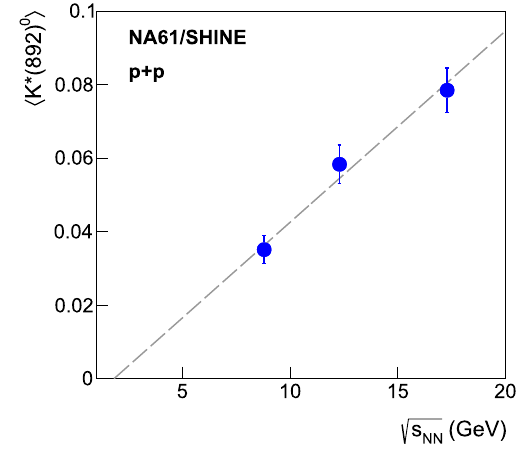
Fig. 9 The energy dependence of (cid:8) K ∗ ( 892 ) 0 (cid:9) in inelastic p+p col- lisions. The previous NA61/SHINE result [9] for p+p interactions at 158 GeV / c is also shown. The mean multiplicities were obtained for 0 < p T < 1 . 5 GeV / c (two lower energies, this analysis) or for the full phase space [9] (the highest energy). The vertical bars represent the total uncertainties (square root of the sum of squares of statistical and systematic uncertainties). The dashed line is added as a guide to the